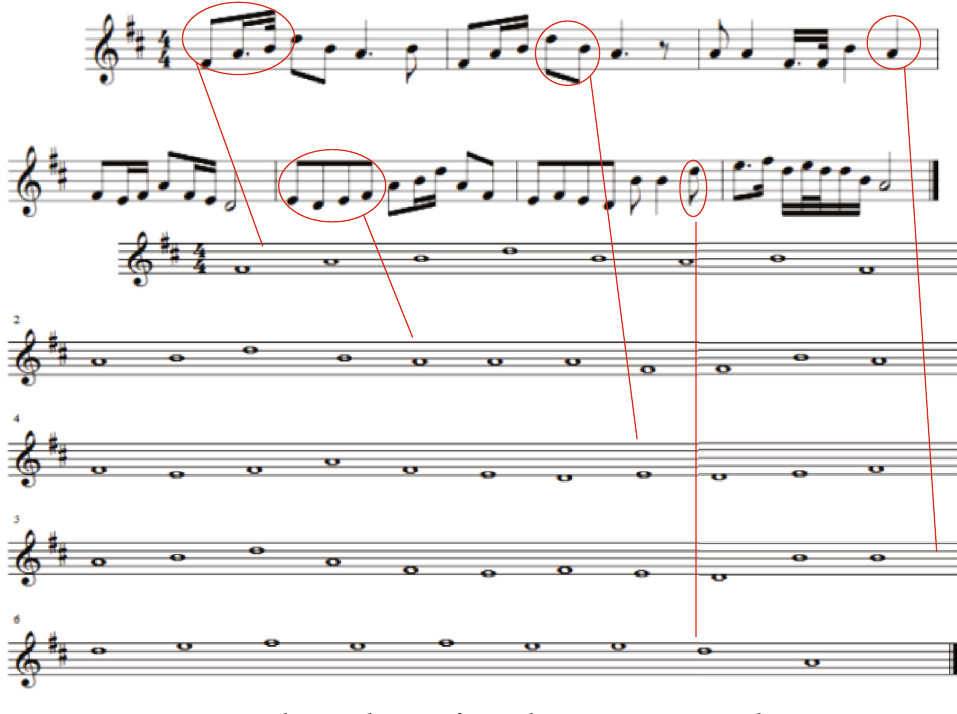
Figure 4: Schematic diagram of interval extraction in music reading.